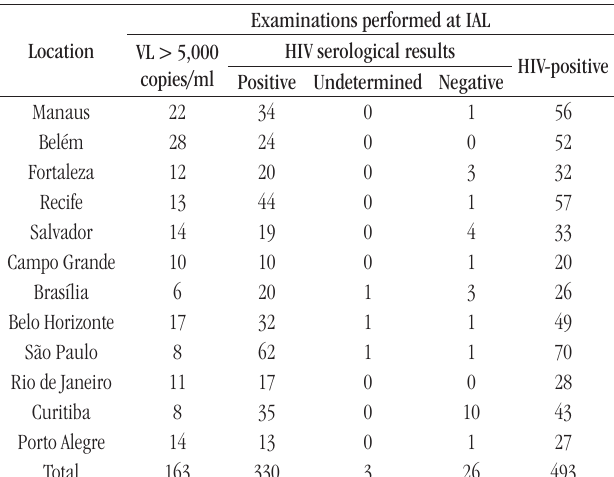
taBLE 4 − Profile of HIV laboratory results performed at the IAL by HIV-1 viral load tests and serological